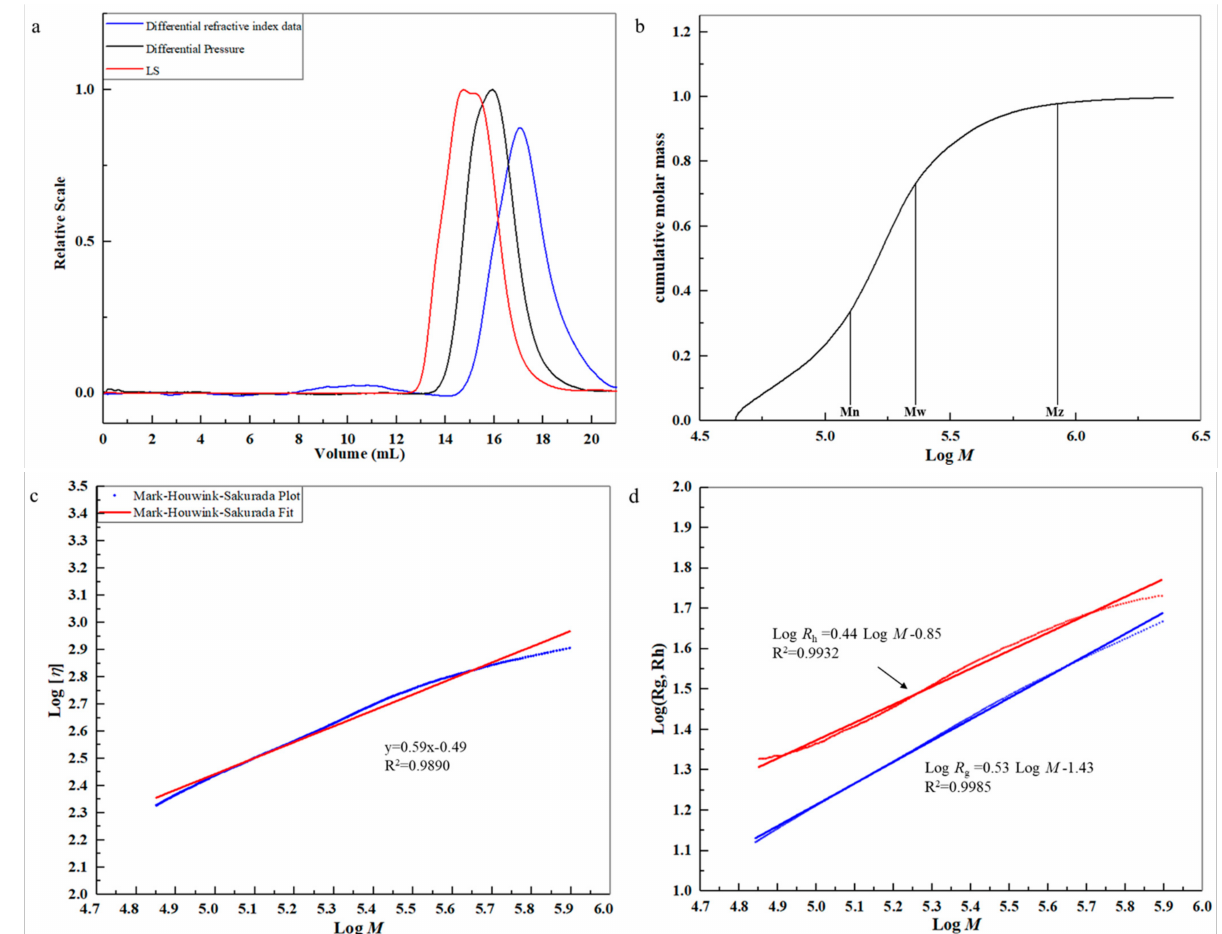
Figure 4. SEC elution profile of HBAX-60 ( a ); double logarithmic plots of M w vs. cumulative weight fraction ( b ); [ η ] ( c ); and R g , R h , and the ratio of R g / R h ( d